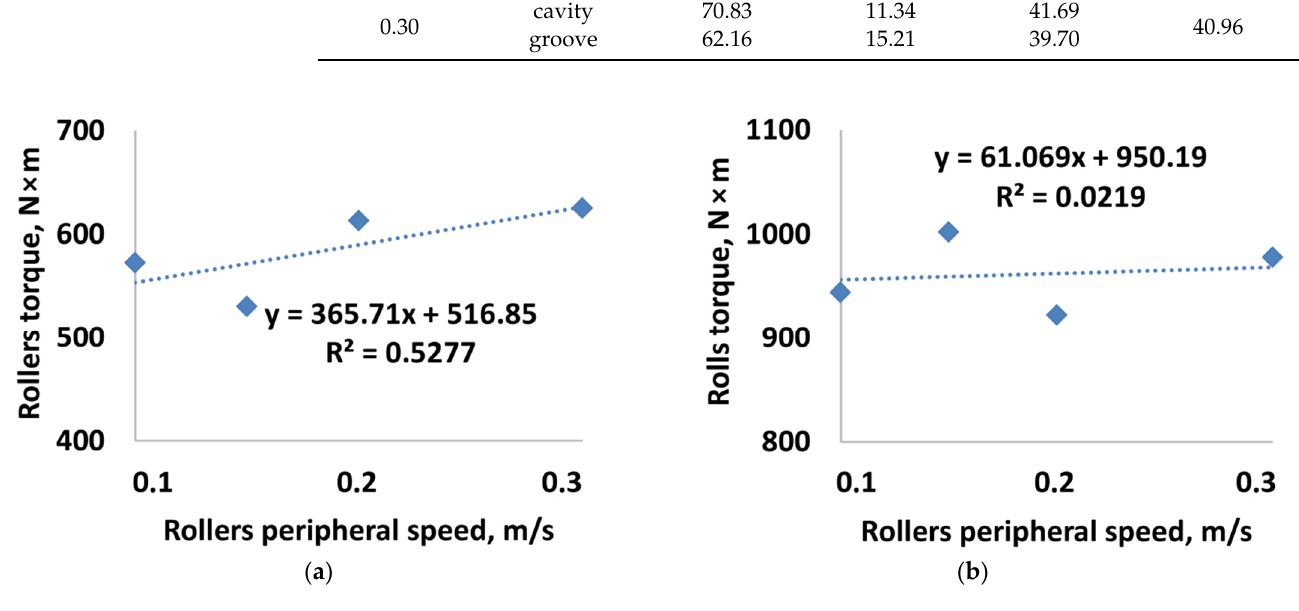
Figure 7. The dependence of rollers torque on the peripheral speed of the rollers when briquetting: ( a )—calcium hydroxide; ( b )—mixture based on copper ore concentrate.